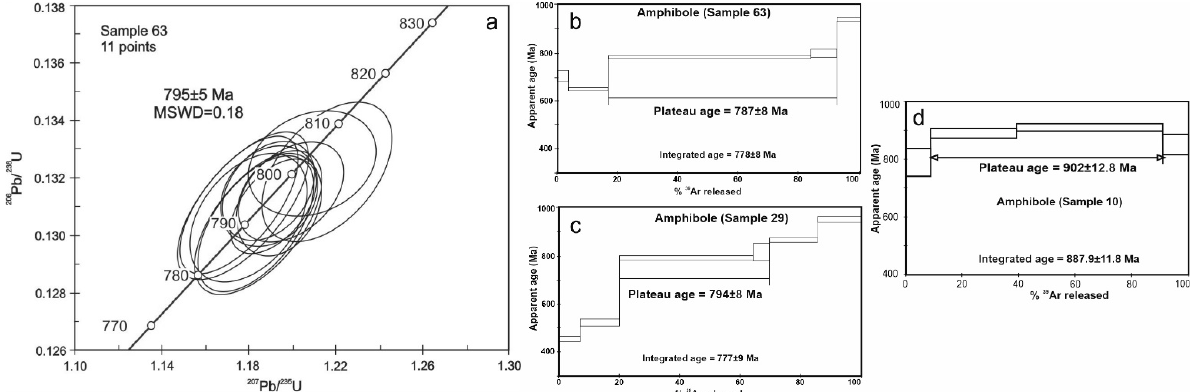
Figure 26. ( a ) Zircon U-Pb concordia diagram for the mafic rock of the dike belt; 40 Ar- 39 Ar hornblende ages for metagabbros of Tis R. ( b ), Garevka R. ( c ) and for orthoamphibolite of the Garevka Complex ( d ). The plateau (arrows) or integrated age is given for each sample. Samples locations are shown in Figure 5.